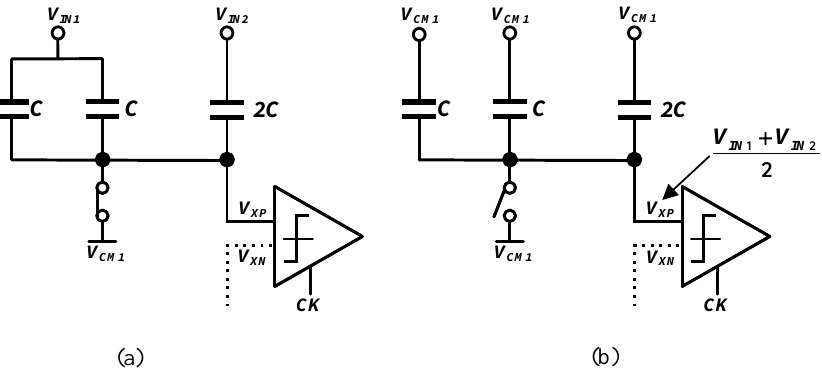
Figure 12. Equivalent circuit of SAR quantizer with embedded feedforward adder. ( a ) Sampling mode. ( b ) Summation